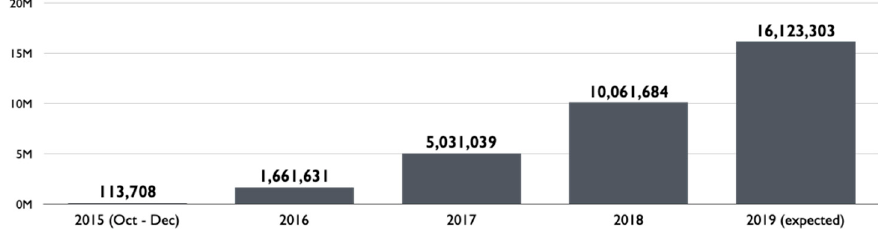
Figure 1. Annual bike sharing trips in Seoul. Data sources: Seoul Institute (https://www.si.re.kr/) and Seoul Facilities Corporation (http://www.sisul.or.kr/).